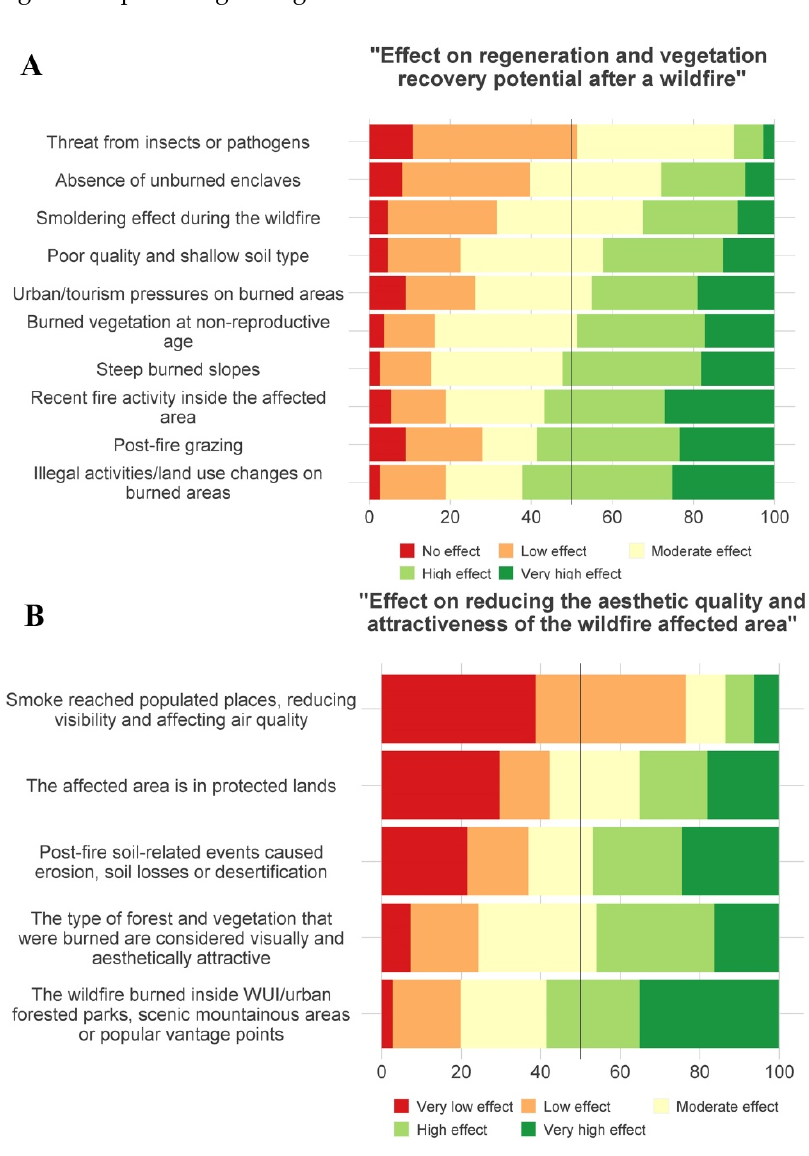
Figure 5. Likert scale rating of the importance of wildfire effects as a percentage of survey responses on the following: ( A ) regeneration and vegetation recovery potential; ( B ) factors that negatively affect aesthetic quality and attractiveness within areas burned by wildfire.